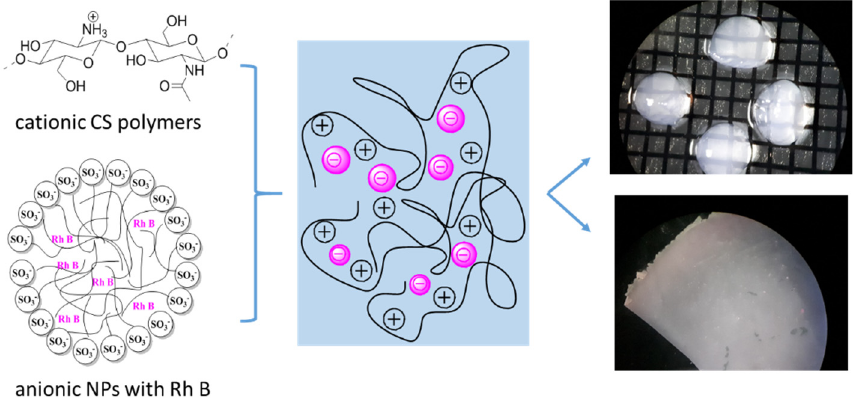
Figure 12. Schematic representation of CS membrane and beads with NPs Rh B-based nanocom- posite.